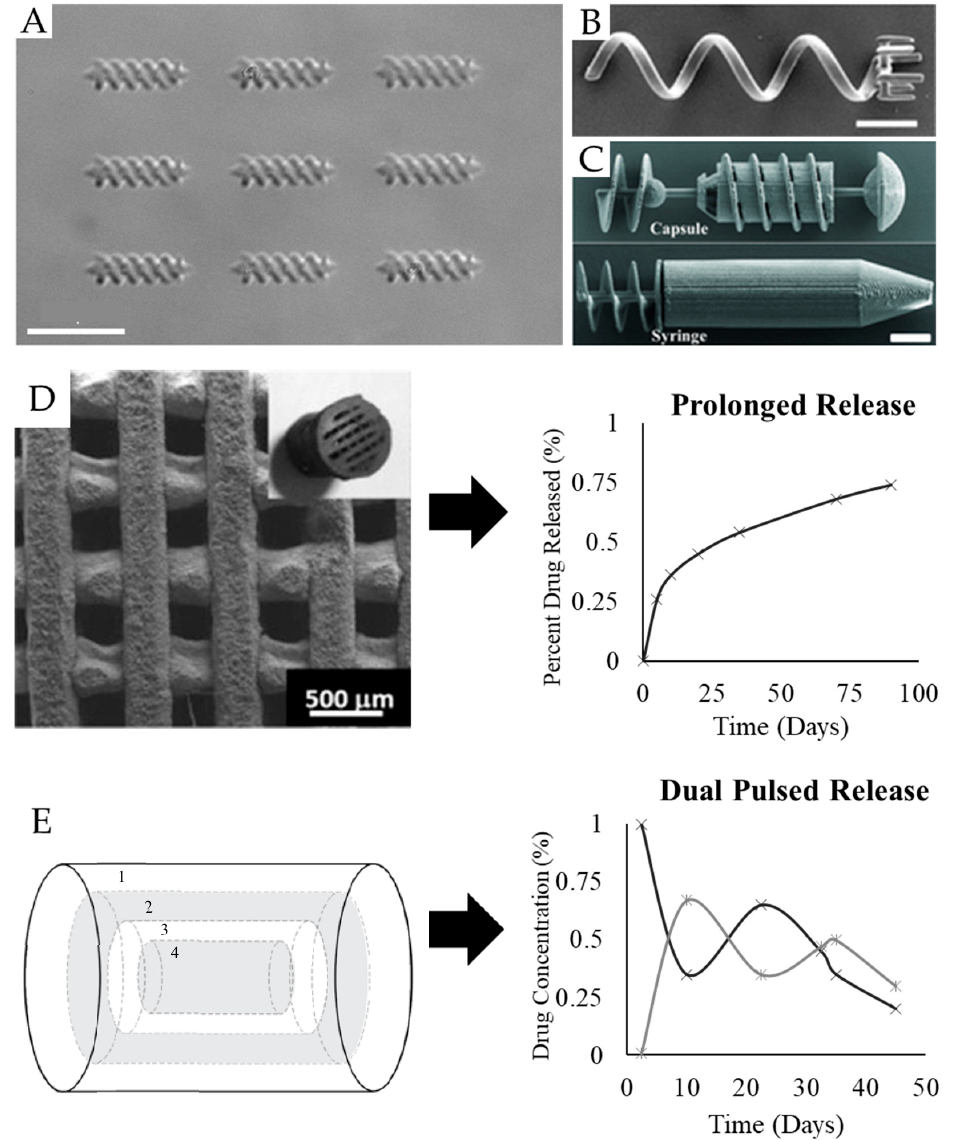
Figure 5. Examples of high-precision targeting in drug delivery. Micro-swimmer double helices ( A )